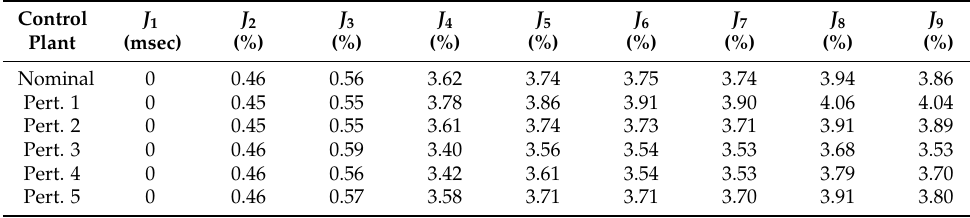
Table 10. Evaluation criteria (Damaged w/ d, El Centro earthquake, Case